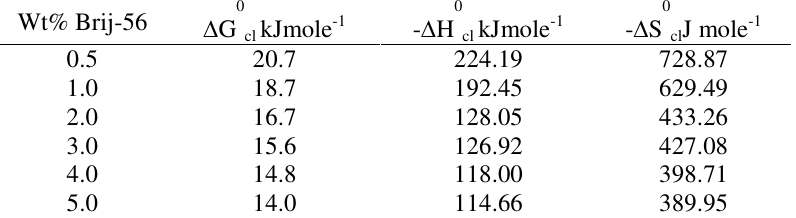
Table 7. Thermodynamic parameter of Brij-56/methionine